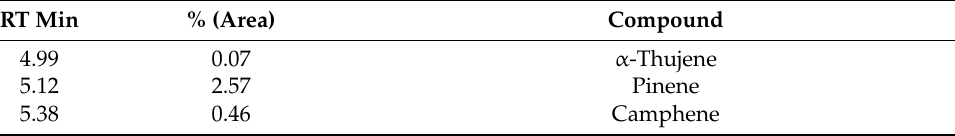
Table 1. Chemical compositions of Litsea cubeba